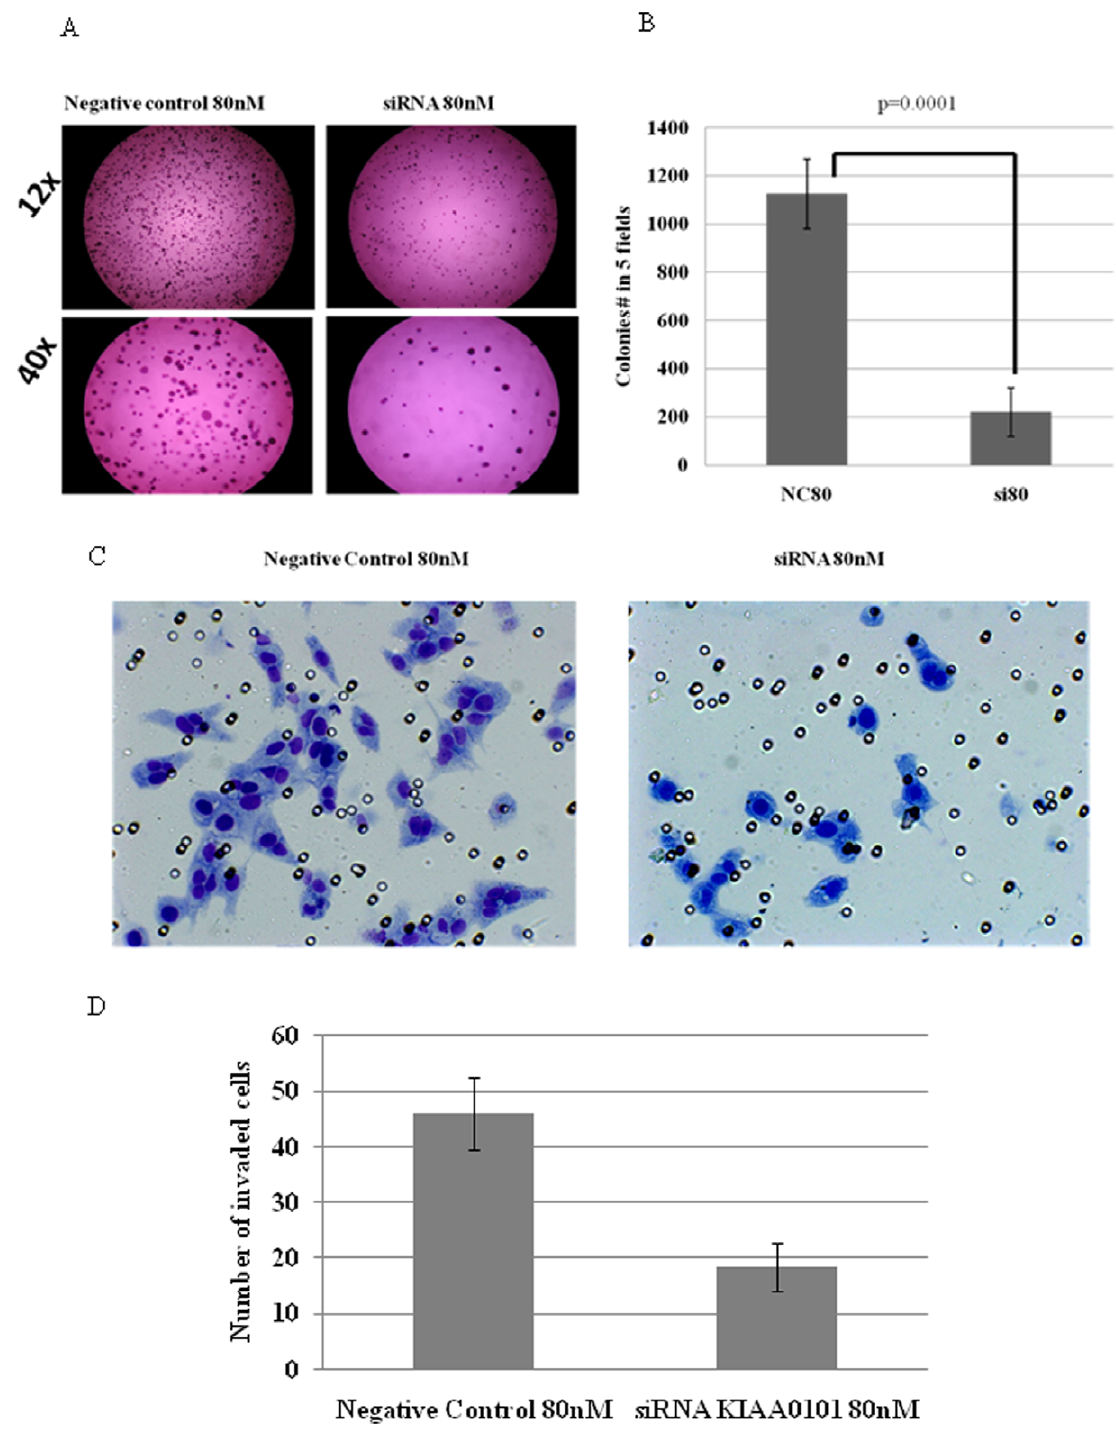
Figure 5. KIAA0101 siRNA knockdown reduced soft agar anchorage independent growth and invasion in NCI-H295R cells. A ) Cells cultured for 15 days in the presence of indicated concentrations of siRNA and negative control. Representative images are shown at 12X and 40X magnifications. B ) The distribution and number of colonies in group treated with KIAA0101 siRNA and negative control group at 80 nM (p=0.001; relative to negative control; NC80= Negative control at 80 nM; SI80 =siRNA at 80 nM). Error bars represent 6 standard error of mean and is representative of four experiments. C ) Invading cells were stained with 0.2% crystal violet and visualized by microscopy. Representative images at 20X following invasion assay. D ) The distribution of number of cells in KIAA0101 siRNA and negative control group. Columns represent the mean 6 standard deviation (SD) of three independent experiments performed in triplicate. *p , 0.05 KIAA0101 siRNA vs. negative control. H295R cells were transfected with negative control or KIAA0101 siRNA at 80 nM for 120 h, followed by an invasion assay for 48 h.